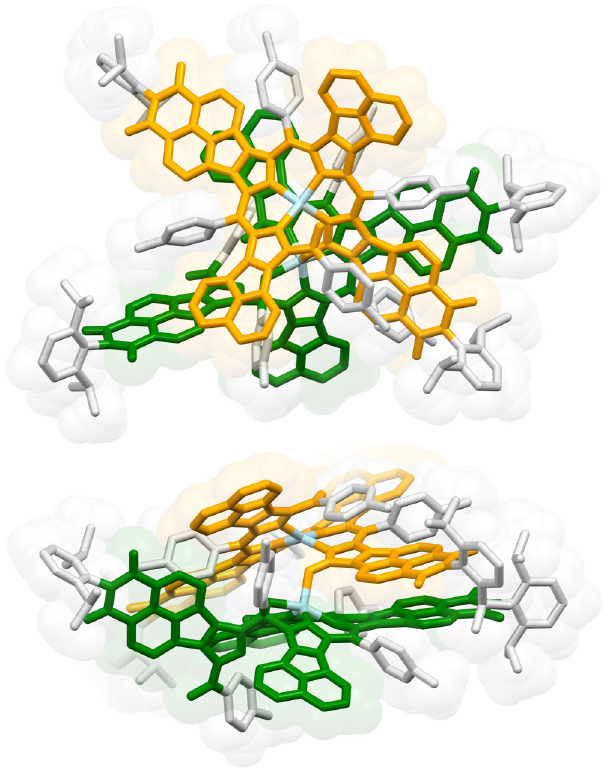
Fig. 3 Molecular structure of dimer 2 obtained in an X-ray crystallographic analysis. Hydrogen atoms and solvent molecules are omitted for the clarity. Subunits A and B and zinc atoms are shown in green, orange, and light blue, respectively. 2,6-Diisopropylphenyl (dipp) and para -tolyl (Tol) substituents are shown in light gray. See Supplementary Fig. 3 for an ORTEP representation of this structure.